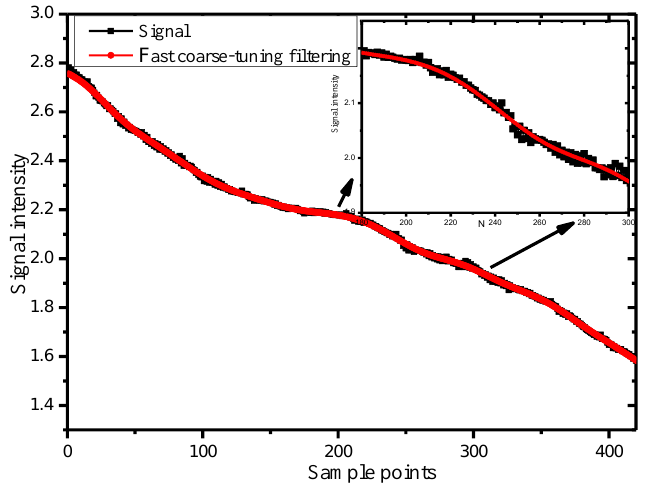
Figure 3. Fast coarse-tuning filtering.